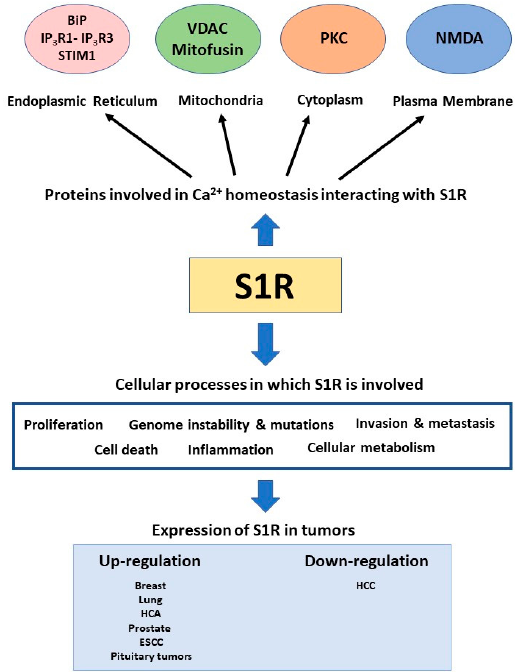
Figure 1. Summary of the involvement of S1R in calcium signaling and cancer.